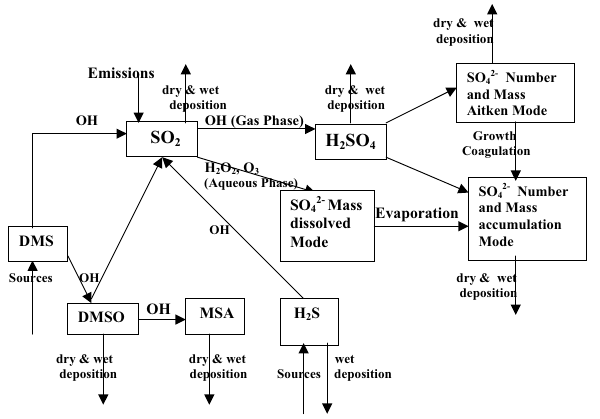
Fig. 1. The schematic representation of the sulphur module in the LMDZ.